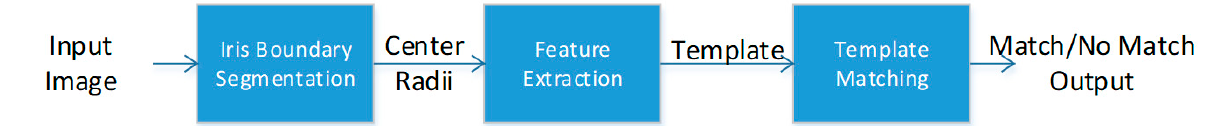
Figure 1. Overview of the iris recognition system.